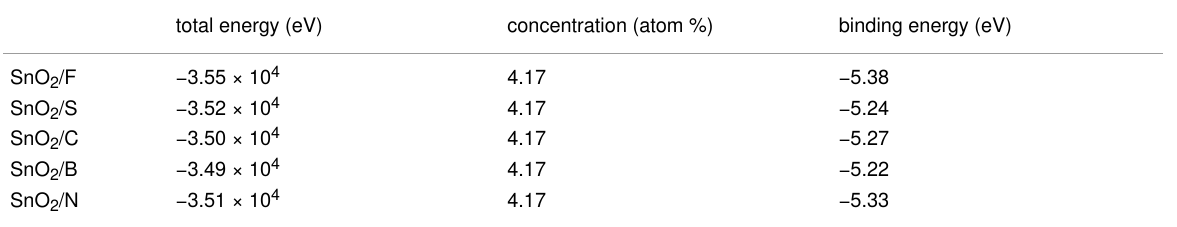
Table 3: Binding energy of SnO 2 with an O atom substituted by a non-metal